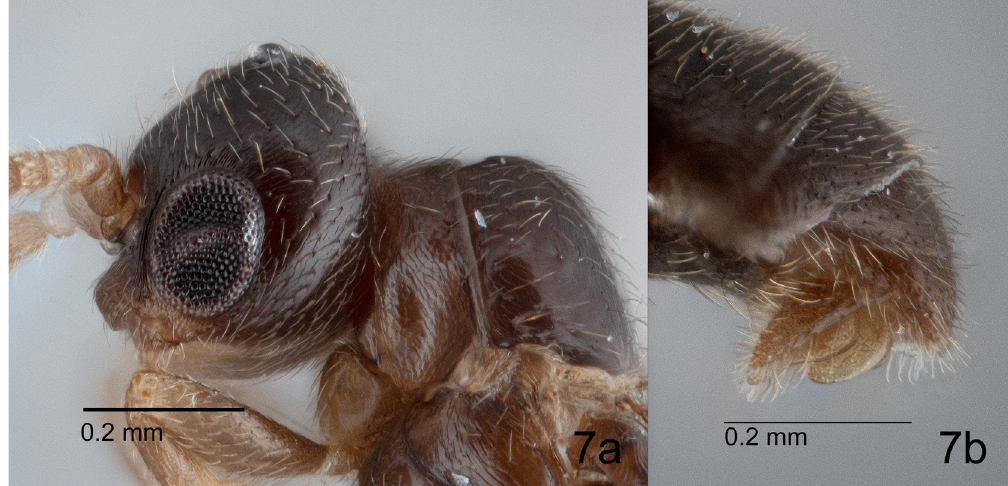
Fig. 7. Rhopalomastix javana Wheeler, 1929, non-type, ♂, Singapore (ZRC_HYM_0000576). a . Head and clypeus in profile. b . Close-up of genitalia in